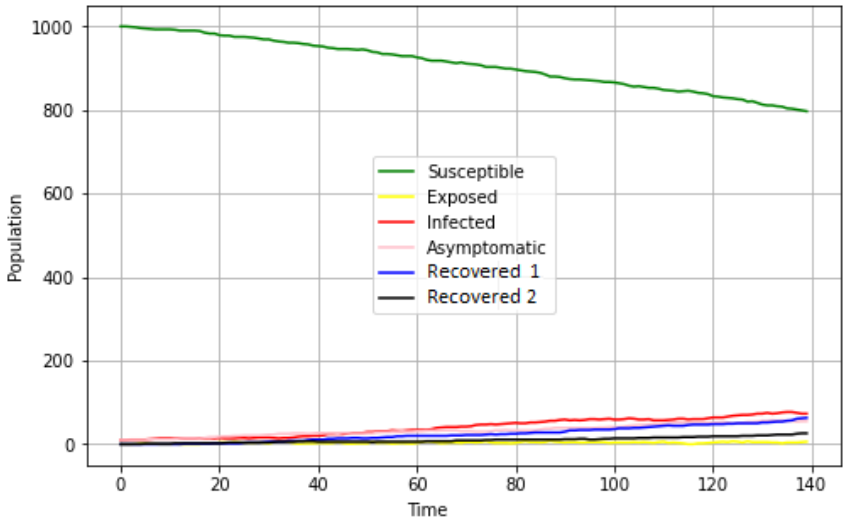
Figure 10. Dynamics of COVID-19 according to the radius of contamination equal to 2